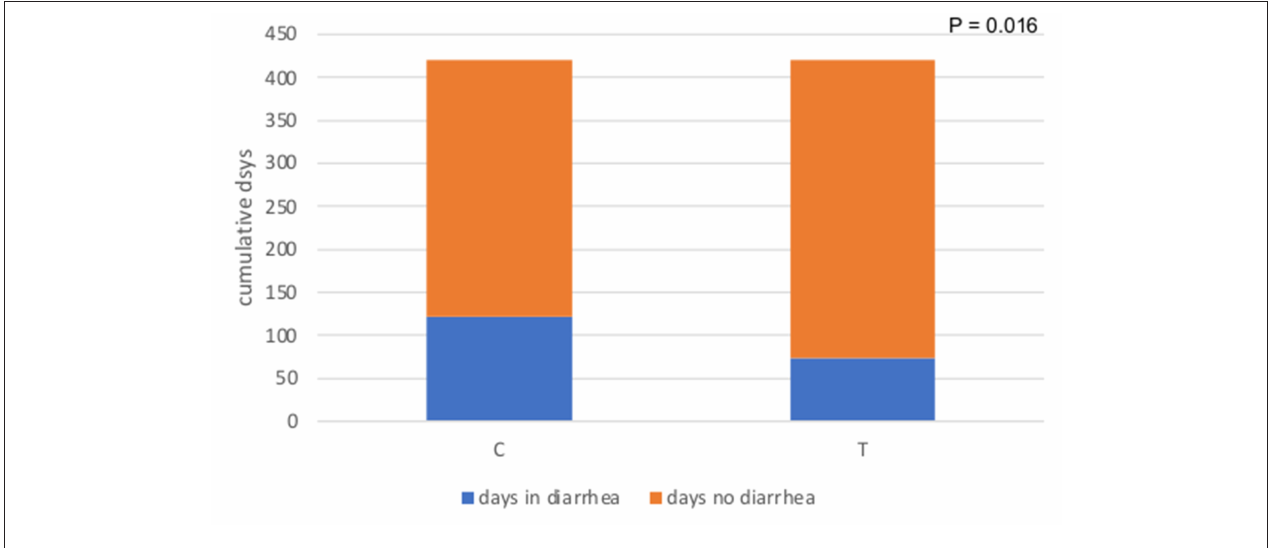
FIGURE 2 | Cumulative number of days spent in diarrhea in the control (C) and treatment group (T).